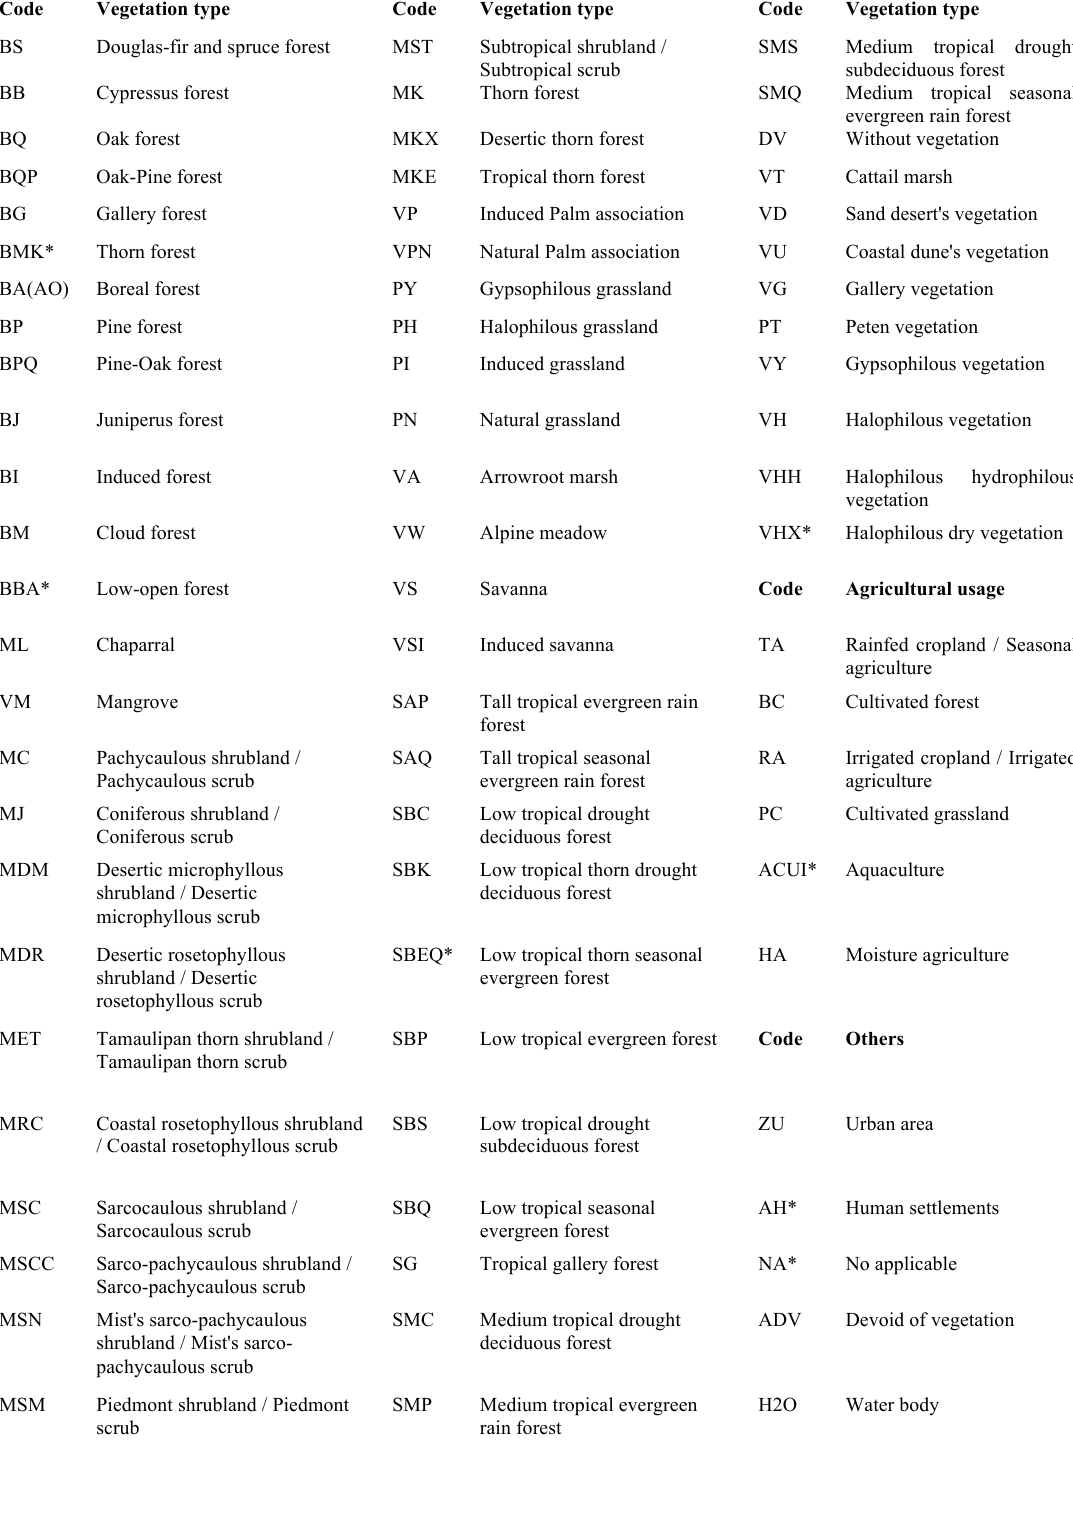
Table 1: INEGI land use and vegetation type classes. Classes labeled with * could not be conserved in the persistent training dataset.